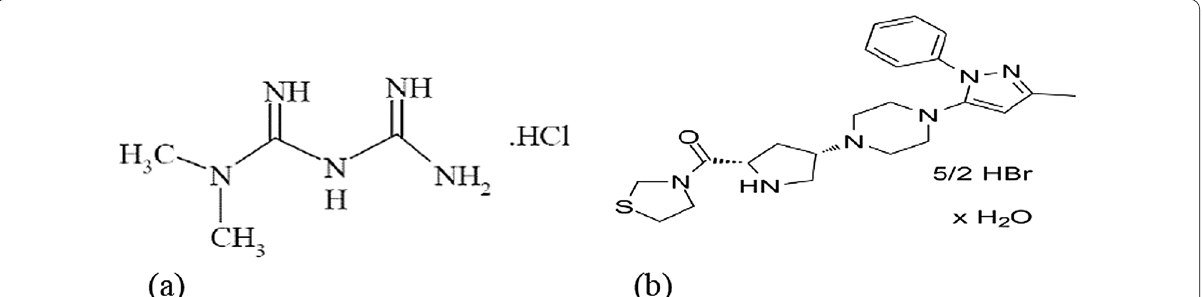
Fig. 1 Structure of a metformin HCl, b teneligliptin hydrobromide